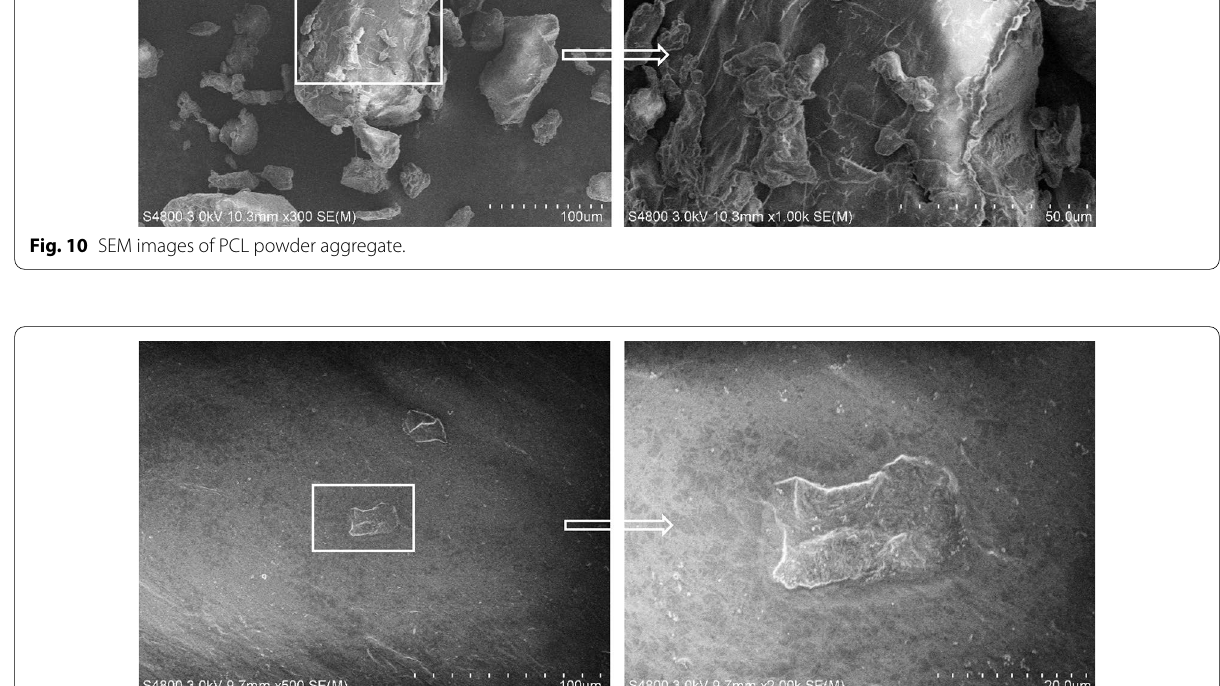
Fig. 11 SEM images of the cross‑sectional area of the PCL powder